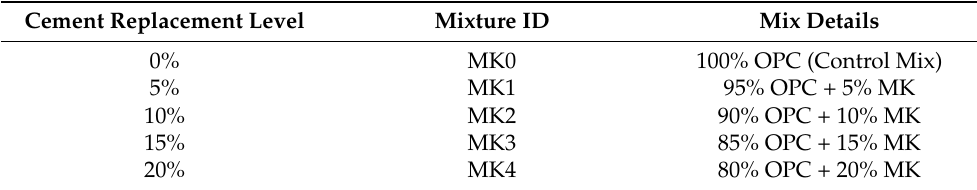
Table 7. Concrete mixture proportions.